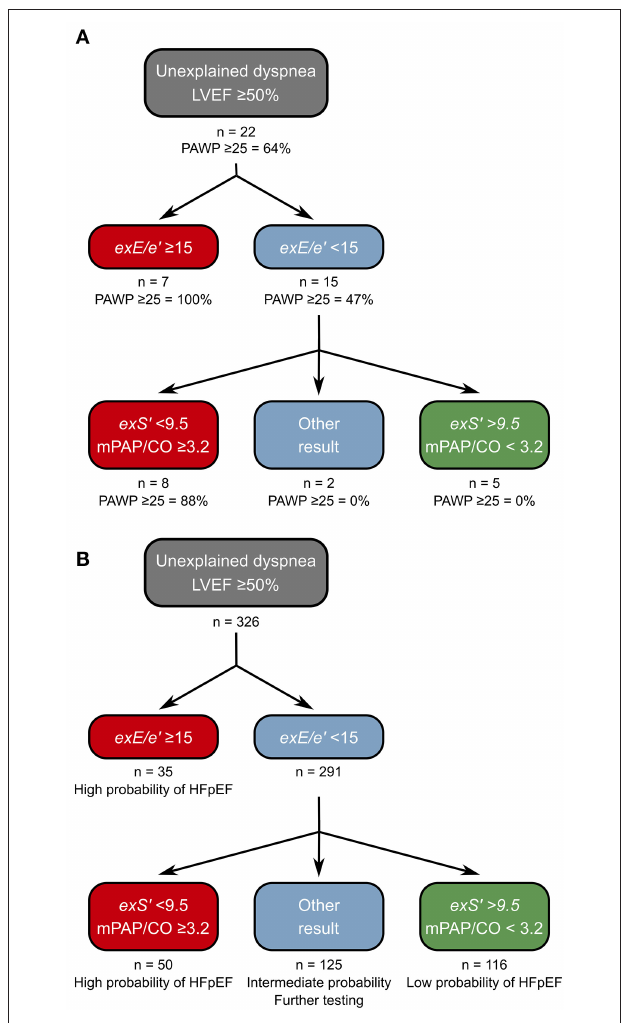
FIGURE 3 | Proposed decision tree for diagnosis of HFpEF on DST. (A) Derivation of the decision tree in the exRHC cohort. Step 1: the existing approach using exE/e’ is maintained. Step 2: exS’ and mPAP/CO slope are determined, HFpEF is considered high probability if exS’ < 9.5 cm/s and mPAP/CO slope ≥ 3.2 mmHg/L, and low probability if both parameters below these thresholds. Thus, all patients with exPAWP ≥ 25 mmHg are identified. A single patient is false positive using this approach. (B) Application of the decision tree to the non-invasive DST cohort. Of 291 patients with normal exE/e’ , 116 (40%) had exS’ > 9.5 cm/s and mPAP/CO slope < 3.2 mmHg/L, we propose that probability of HFpEF is low in these patients. A total of 50 patients (17%) had low exS’ and elevated mPAP/CO slope, we propose that probability of HFpEF is high in these patients. In the remaining 125 patients, we propose to perform additional investigations before establishing a diagnosis of HFpEF. CO, cardiac output; exE/e’ , highest septal E/e’ recorded during exercise; exS’ , S’ at peak exercise; mPAP, mean pulmonary artery